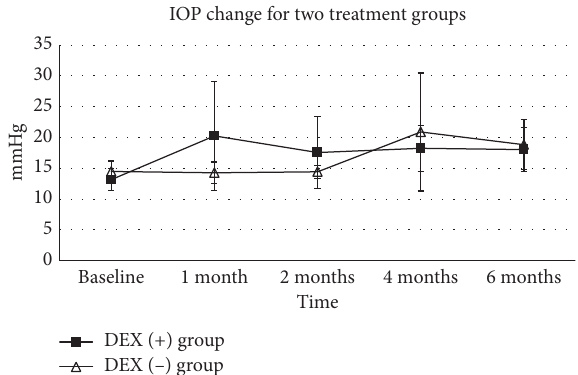
Figure 6: Intraocular pressure (IOP) change for the DEX (+) group and DEX ( − ) group. The IOP at the baseline and 1, 2, 4, and 6 months during the follow-up period is shown in this figure. The change of IOP for the DEX(+) group was defined with a line chart with solid square, while the change of IOP for the DEX(-) group was defined with a line chart with open arrowhead ( ∗ P < 0 . 5, ∗∗ P < 0 . 1, and ∗∗∗ P < 0 .